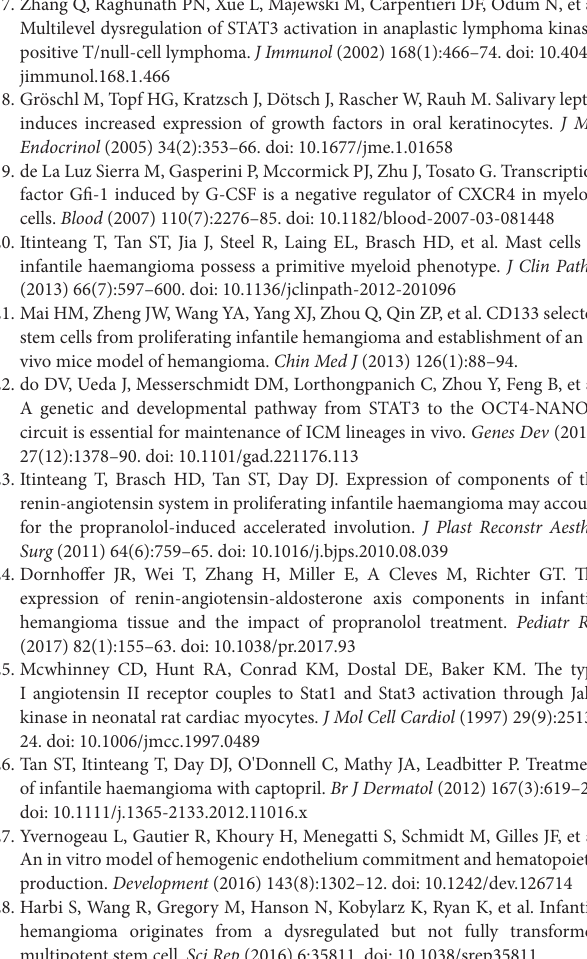
presence of pSTAT3 detected as two thick bands at approximately 86 and 79 kDa (B) and human liver demonstrating the presence of pSTAT5 as two bands at approximately 80 and 90 kDa (c)